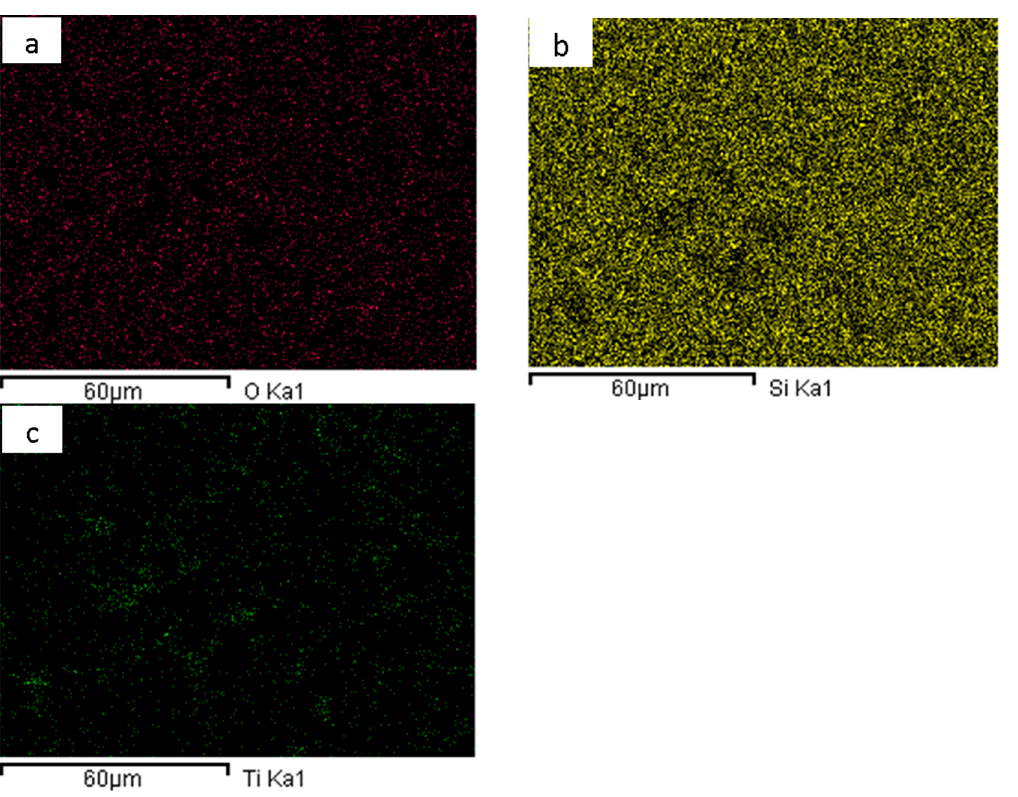
Figure 3. EDS images of TiO 2 /SiO 2 films. Distributions of ( a ) O, ( b ) Si, and ( c ) Ti.